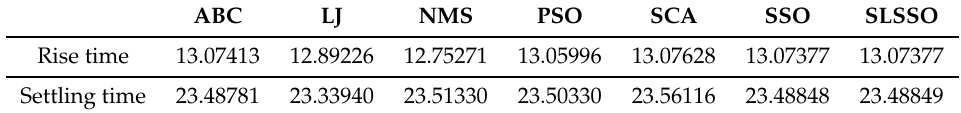
Table 5. Comparisons of performance for control loop I.